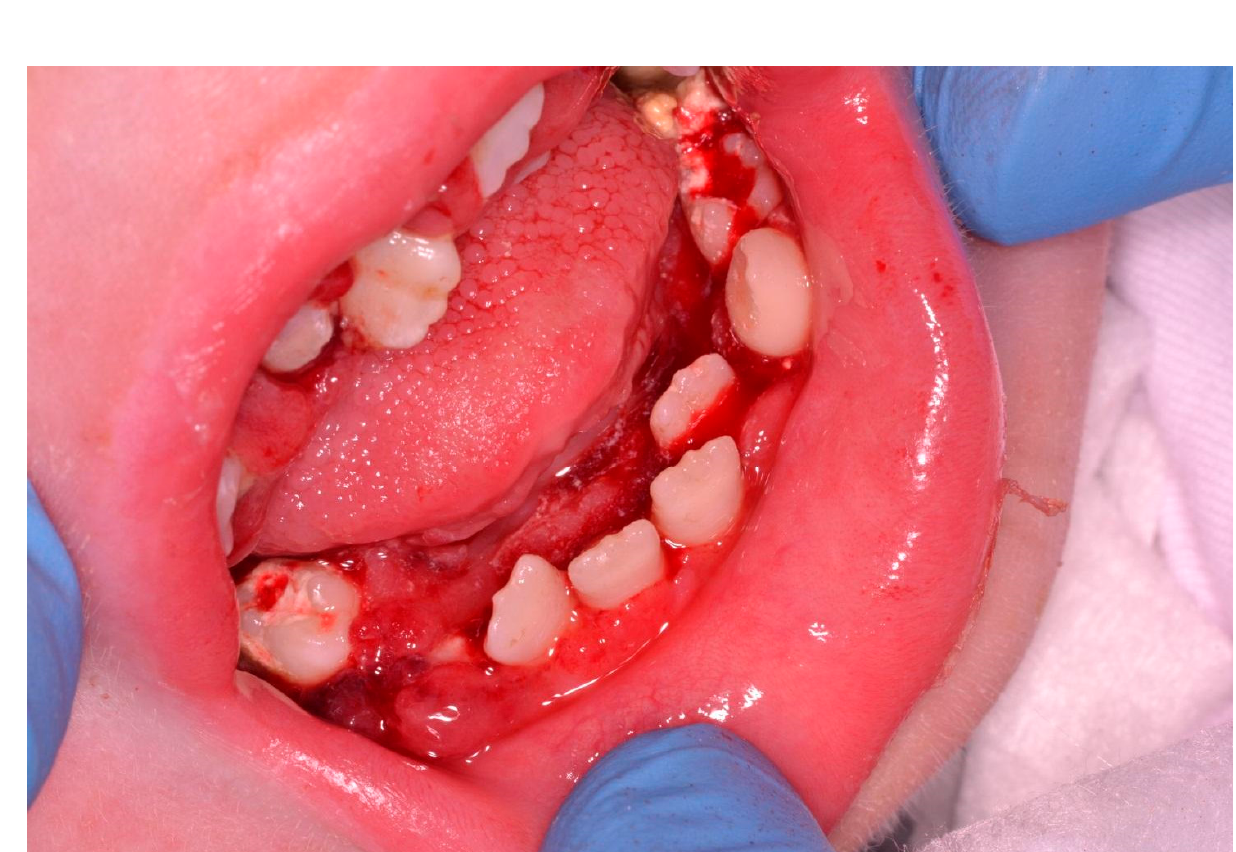
Figure 3. Calculus accumulation and periodontitis in a patient with special needs.